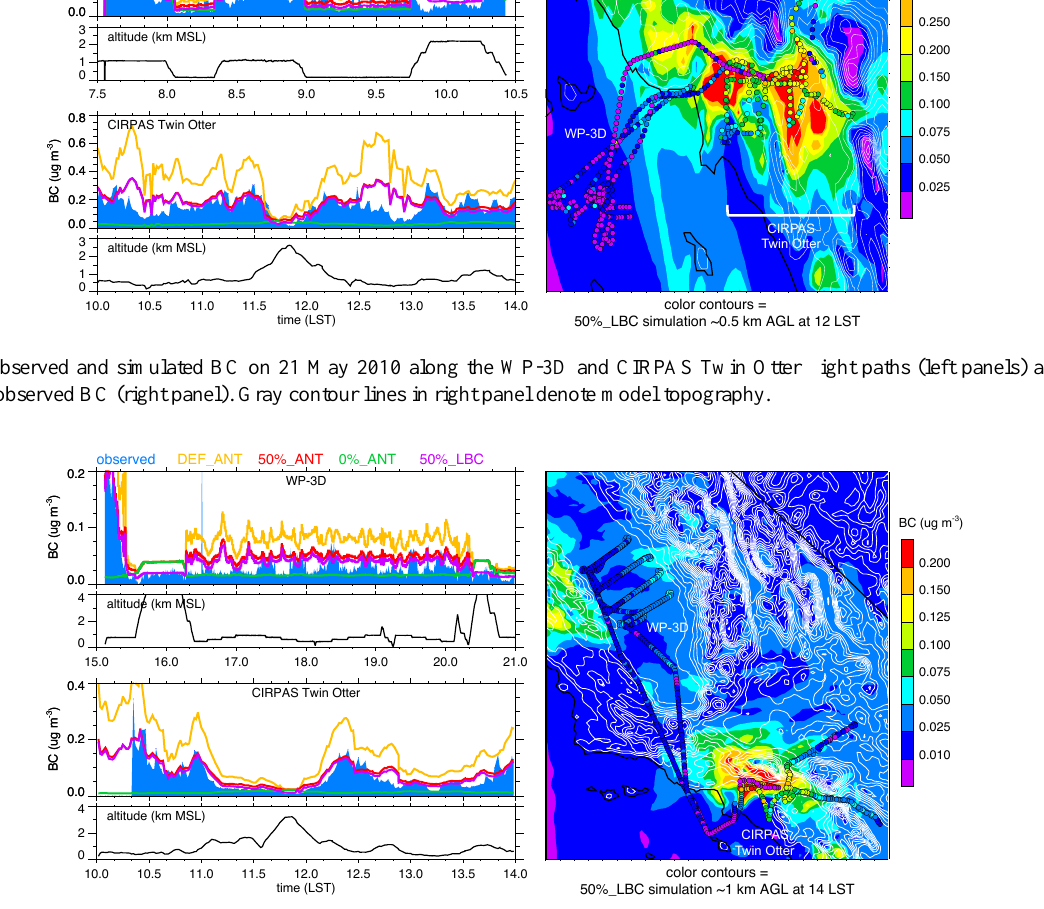
Figure 11. Same as Fig. 10, except for 24 May